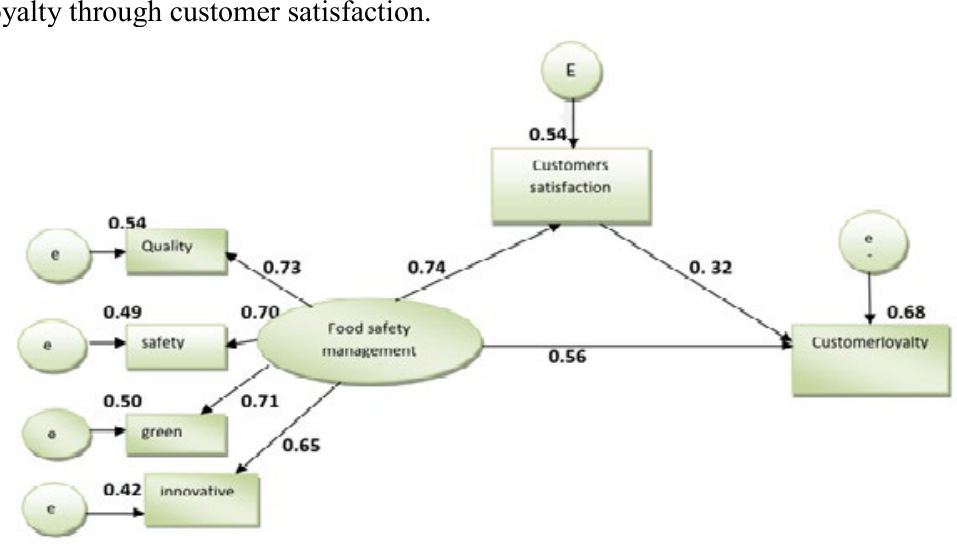
Fig. 2. A model showing relationships of study variables,